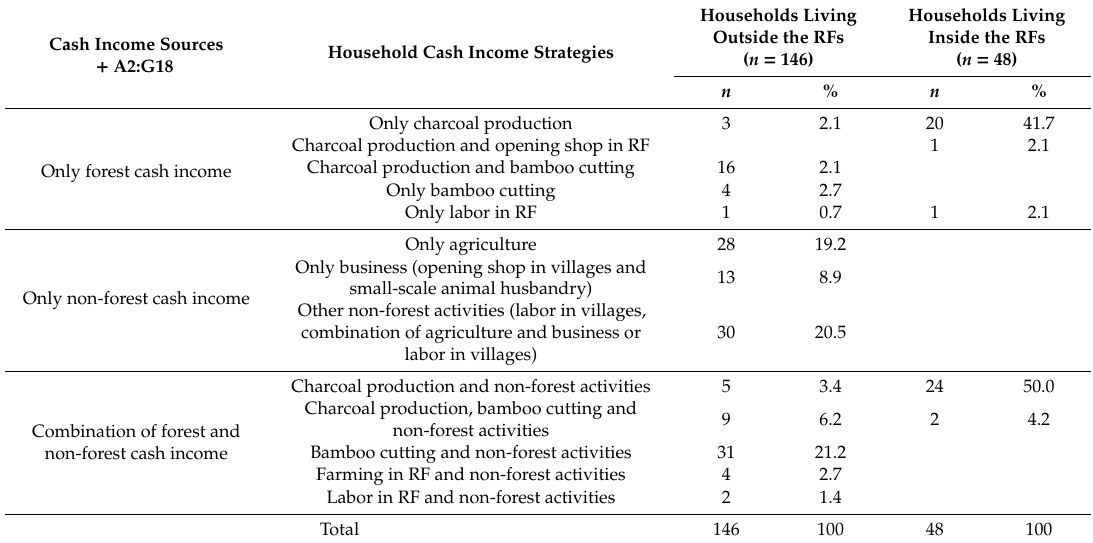
Table 1. Cash income sources and household cash income strategies found in this